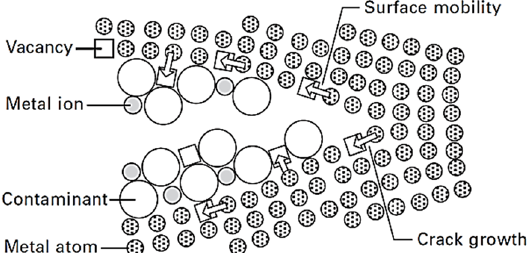
Figure 2. SCC mechanism: cracking propagation of the crack tip due to the surface mobility induced by corrosive environment 4,25 .